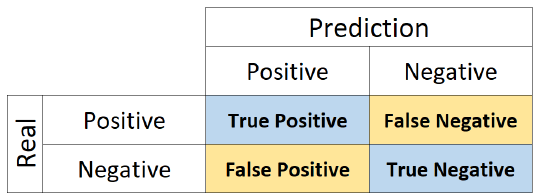
Figure 11. Interpretation of data from the confusion matrix.